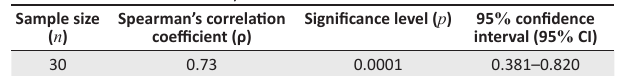
TABLE 2: Test–retest reliability. Sample size ( n )